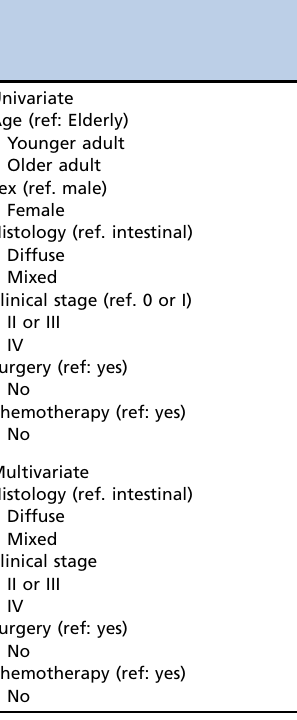
Table 3 - Hazard ratios of death for all patients and for younger adults.